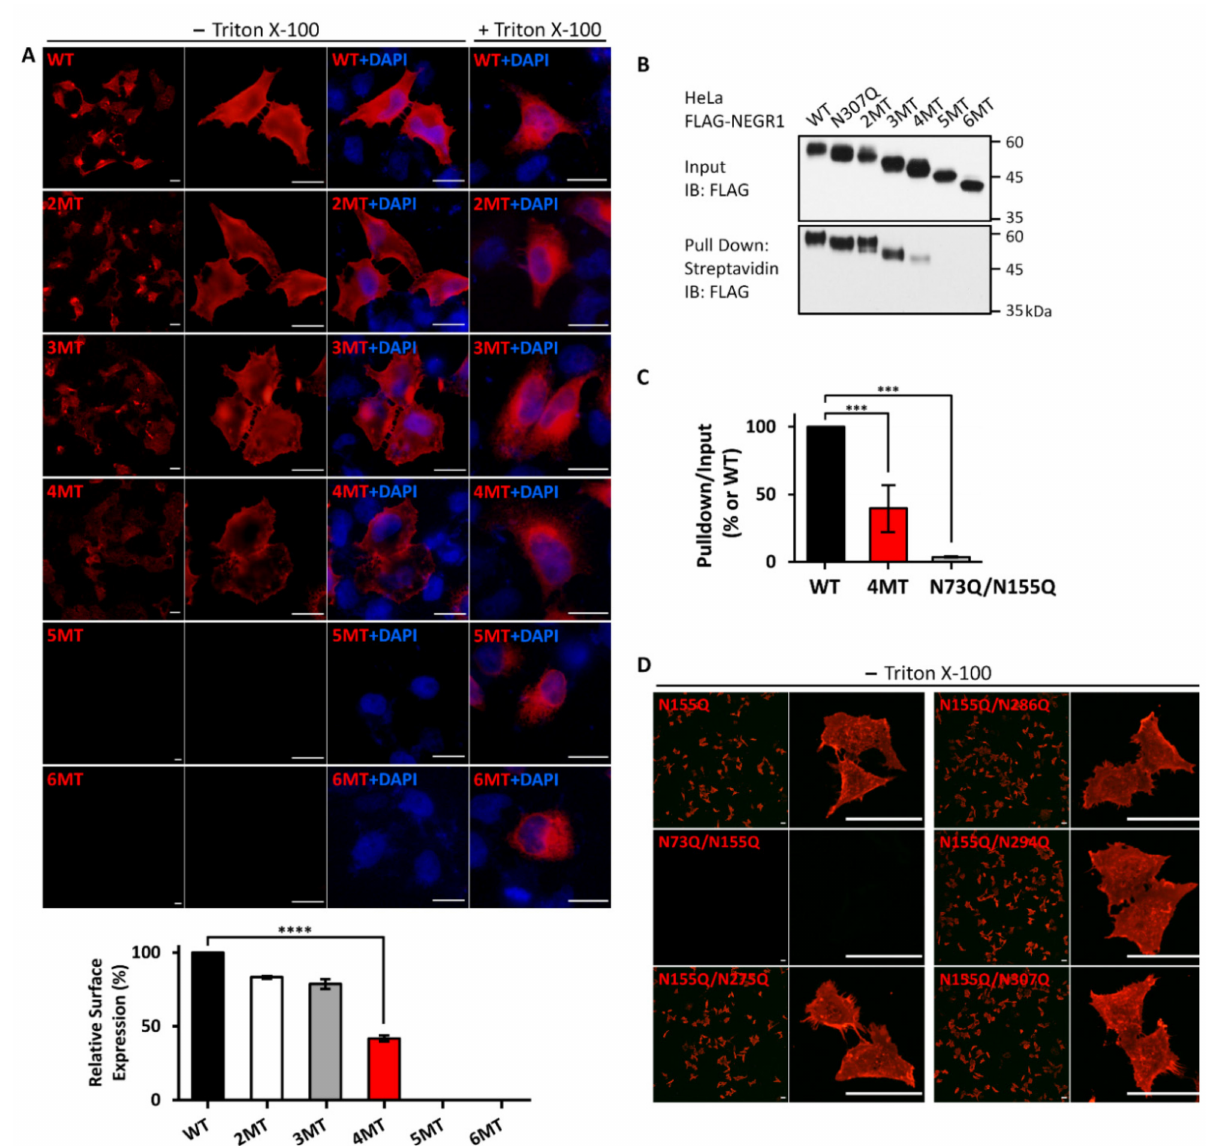
Figure 3. Membrane targeting of NEGR1 N -glycosylation mutants. ( A ) Immunofluorescence mi- croscopy analysis of NEGR1 mutants. After transfection, HeLa cells were immunostained with anti-FLAG antibody with or without 0.1% Triton X-100. After incubation with Cy3-conjugated sec- ondary antibody, images were captured using the Olympus BX51 fluorescence microscope. Scale bar = 50 µ m. Cell surface expression was determined by calculating the relative fluorescence intensities in non-permeabilized cells after normalization to those in permeabilized cells. **** p < 0.0001. Error bars represent standard deviations (SD). ( B ) After transfection, HeLa cells were labeled with sulfo- NHS-SS-biotin using the Pierce Cell Surface Protein Isolation kit. Then, biotinylated proteins were isolated with streptavidin pulldown and subjected to immunoblotting using anti-FLAG antibody. ( C ) The surface to total ratio of 4MT and N73Q/N155Q mutant was calculated and normalized to that of WT. The data represent the average of three independent experiments ± SD. *** p < 0.001. ( D ) Membrane targeting of double mutants commonly containing N155Q. Cells were immunostained using anti-FLAG antibody under non-permeabilized conditions. Images were acquired using the Zeiss LSM 880 confocal microscope. Scale bar = 50 µ